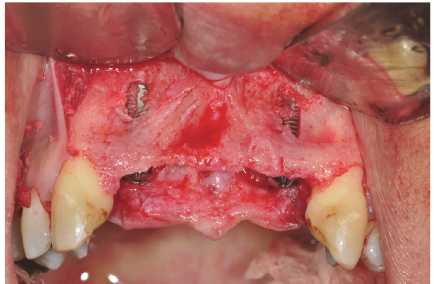
Figure 3: The implants installed.